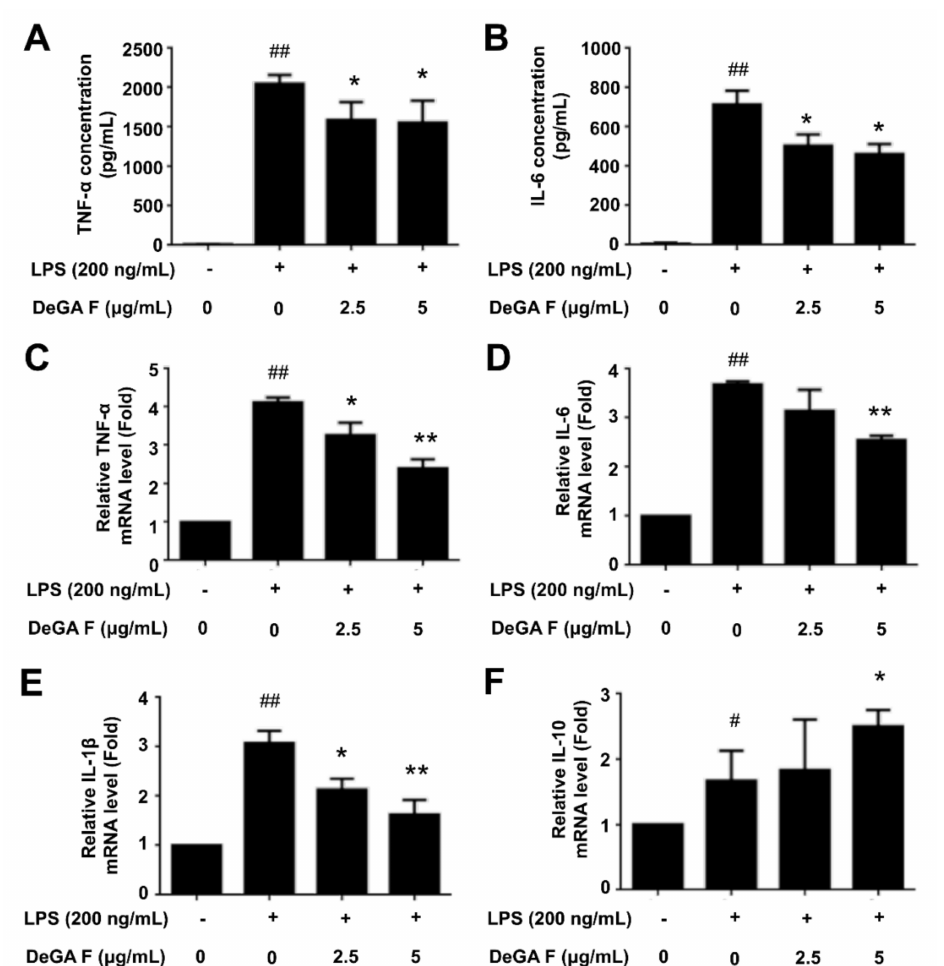
Figure 2. DeGA F affected the secretion and mRNA levels of the inflammatory cytokines in LPS-stimulated BV-2 cells. Cells were pretreated with DeGA F for 1 h, and then exposed to LPS for another 24 h. ( A , B ) Secretion levels of TNF- α and IL-6 in the cell culture medium were determined by relative ELISA kit. The mRNA expression levels of TNF- α ( C ), IL-6 ( D ), IL-1 β ( E ), and IL-10 ( F ) were measured by qPCR analysis. – and + represented the absence or presence of LPS (200 ng / mL), respectively. # p < 0.05 and ## p < 0.01 compared with blank group. * p < 0.05 and ** p < 0.01 compared with the LPS group ( n =